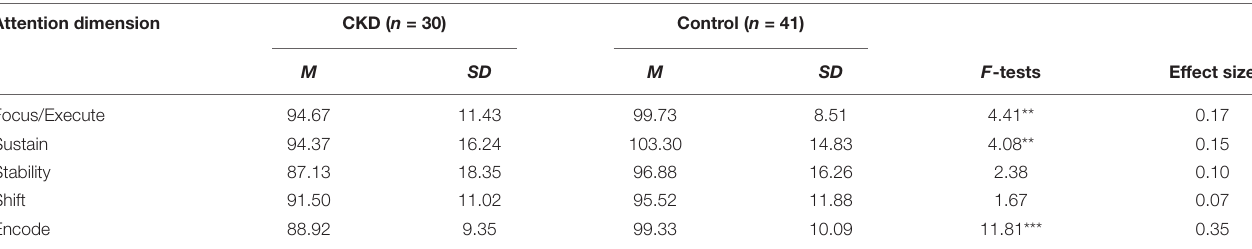
TABLE 2 | Attention dimensions by group adjusted for chronological age and maternal education. Attention